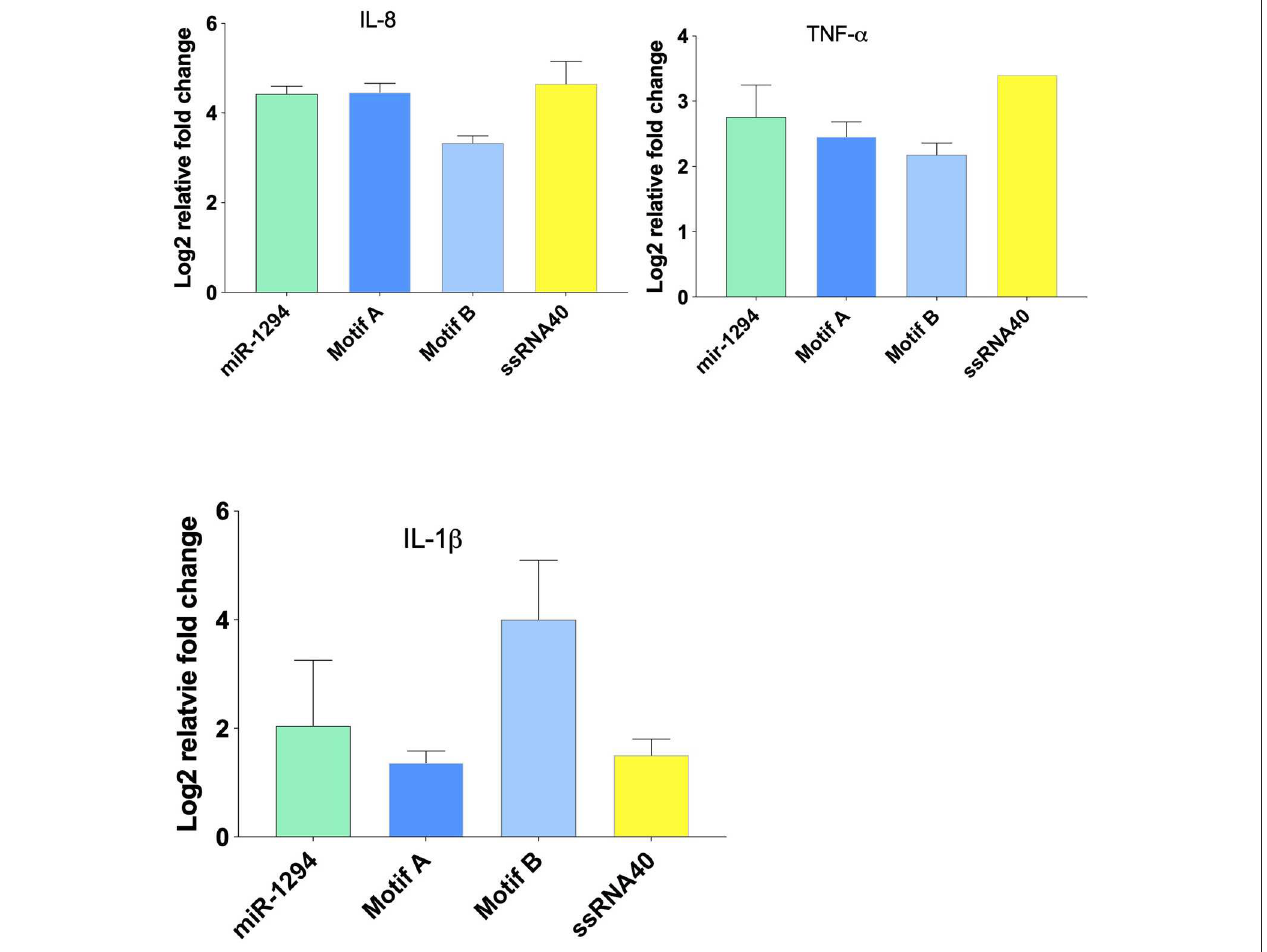
FIGURE 2 | miR-1294 and its core motifs induce expression of IL-8, IL-1 β , and TNF α mRNA. HEK-Blue TM hTLR8 cells (Invivogen, San Diego, CA), were incubated with miR-1294 mimic and its two core motifs (Motif A-AUUGUUG and Motif B- AUUGUUA) for 24h. ssRNA40, a TLR8 agonist, was used as a control. All experiments were replicated three